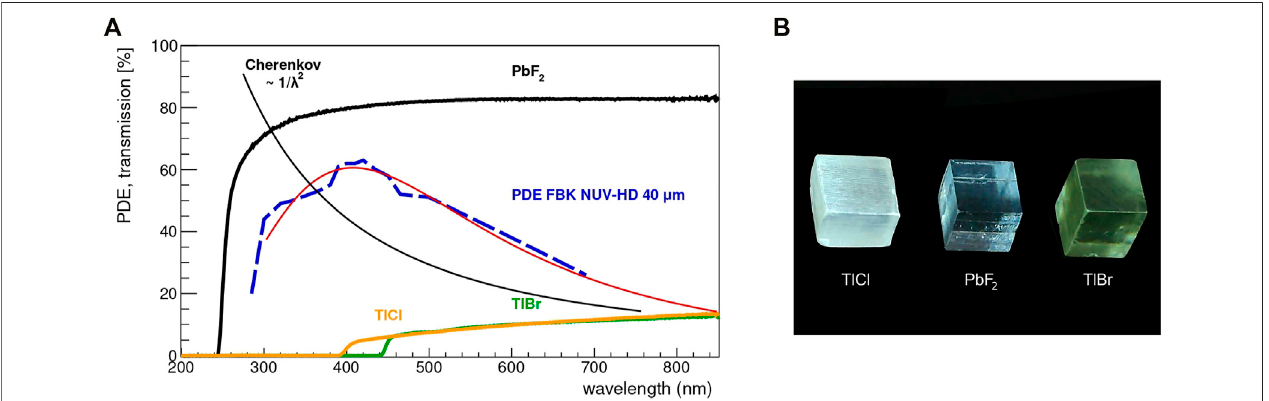
FIGURE 1 | (A) Transmission of 3 × 3 × 3 mm 3 PbF 2 , TlBr, and TlCl crystals. The surface conditions of TlBr and TlCl crystals (unpolished) are not optimized as the aim ofthismeasurementistoshowthe cutoff wavelengths.Greater transmissionisexpectedforpolished TlBrand TlCl crystals. Inthe simulations, transmissionisset to 100% independently from the material, since the roughness of the surfaces is separately introduced as well as Fresnel re fl ections. The PDE of the SiPM is taken from [2] and estimated between the measured points using a polynomial fi t function. (B) 3 × 3 × 3 mm 3 TlCl, PbF 2 , and TlBr crystals observed using the microscope, showing the difference between the polished PbF 2 surface and the unpolished semiconductor crystal